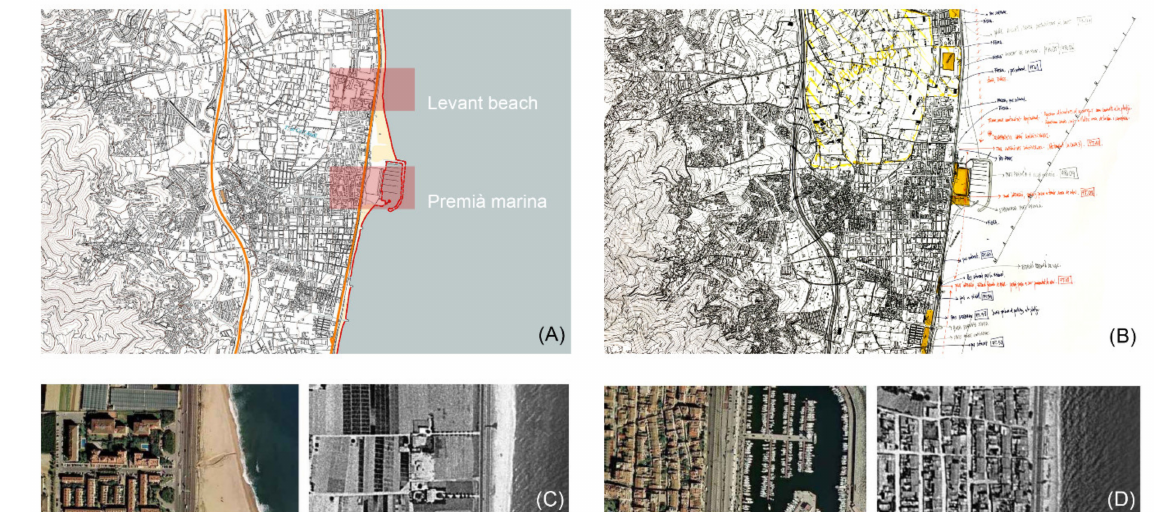
Figure 4. Cartographic analysis based on fieldwork and archive mining (Source: authors’ own). ( A ) Digital mapping of the Premi à de Mar (Sea Premi à ) area. ( B ) Fieldwork draft map of Premi à de Mar. ( C , D ) Sample of diachronic analysis by comparison between the current aerial view and the view from an American flight (1956)